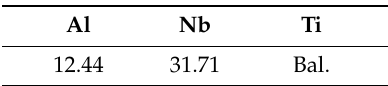
Figure 1. Microstructure of Ti 3 Al-based alloy. Table 1. Chemical composition of Ti 3 Al-based alloy titanium alloy (wt%).